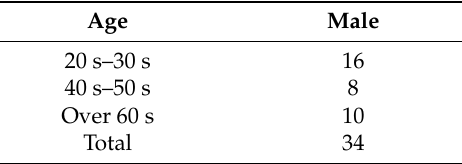
Table 2. Age and gender of